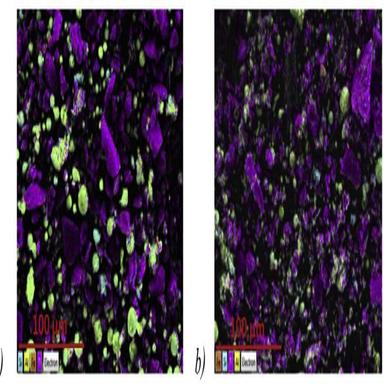
a) Elemental Mapping overlapped to a SEM image for catalyst FA-USA (Si in light blue; Al in yellow; Fe in orange; Ti in purple). b) Elemental Mapping overlapped to a SEM image for catalyst FA-USB (Fe in orange; Si in light blue; Ti in purple; Al in yellow).